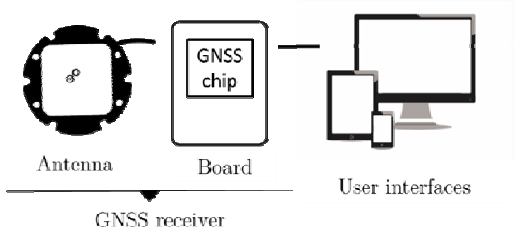
Figure 1 : Hardware components of a GNSS receiver